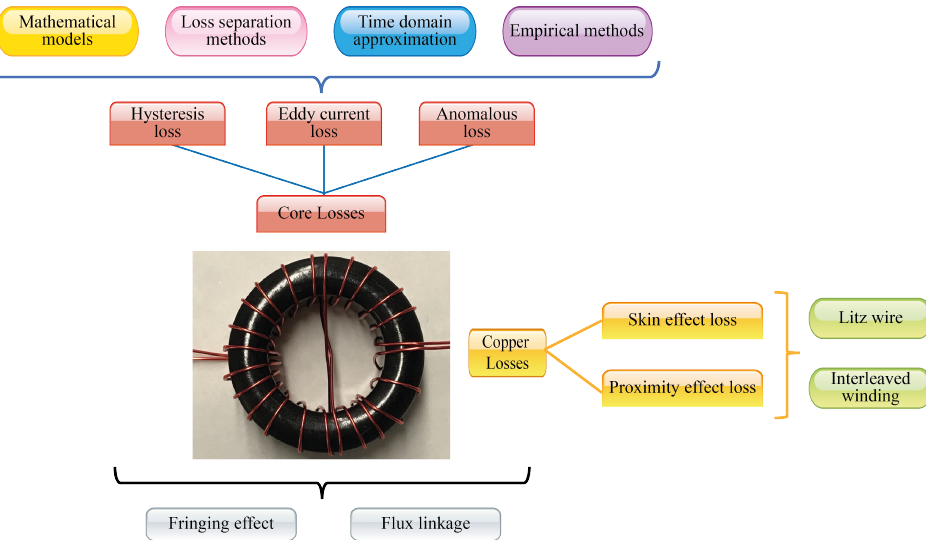
Figure 2. Types and classification of losses presented on magnetic components. Source: Adapted from